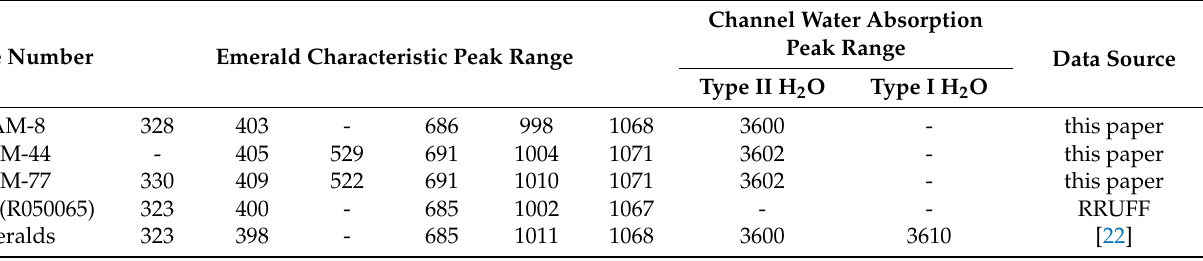
Table 2. Table 2. Peak positions of the emeralds (cm − 1